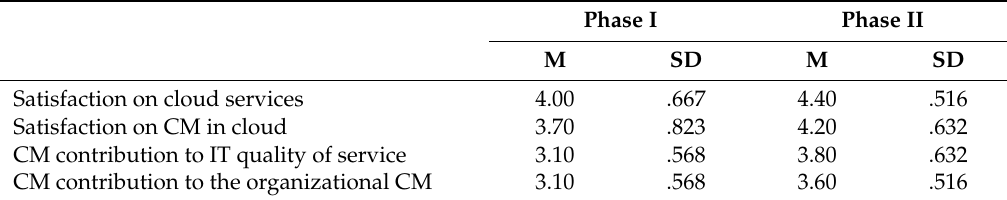
Table 5. Descriptive statistics on the compliance evaluation sheet. Case Study